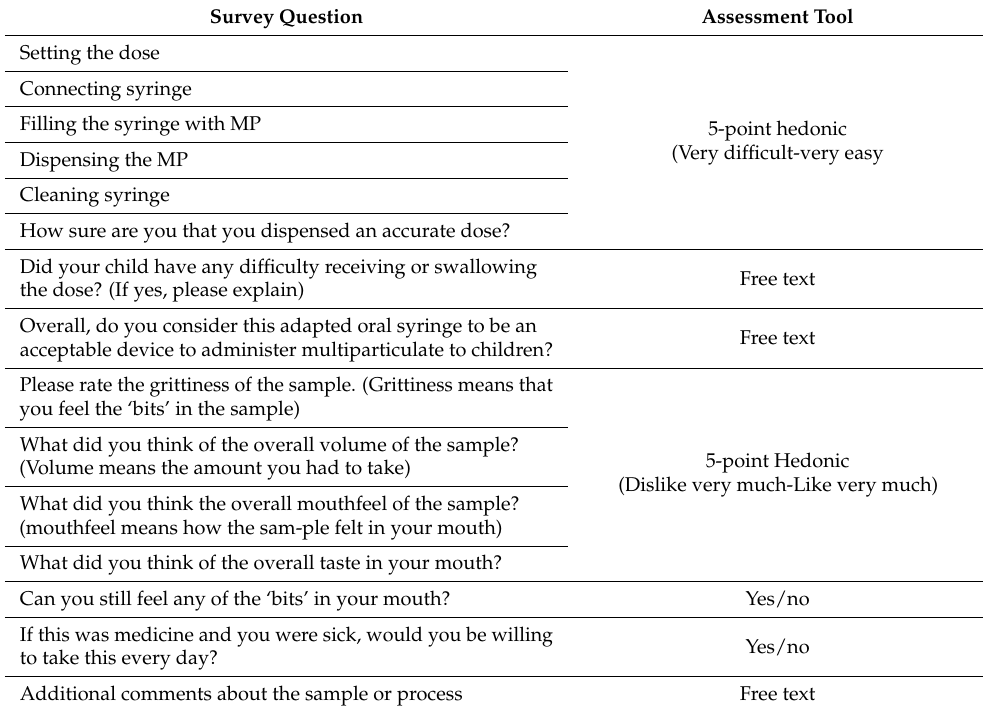
Table A2. Survey questions for parent and child participants ages 5–12.